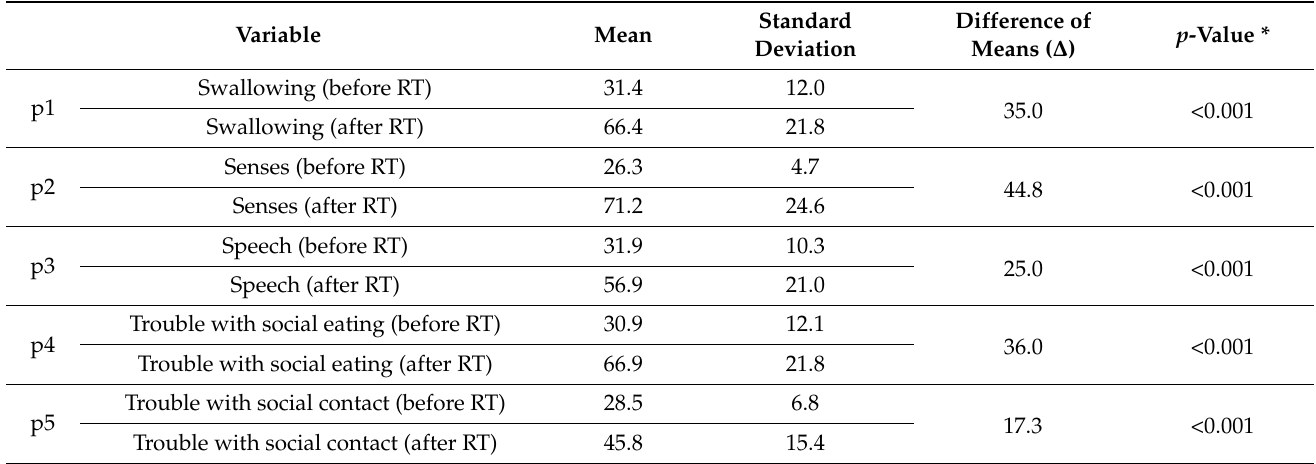
Table 4. Analysis of the determinants of quality of life (EORTC